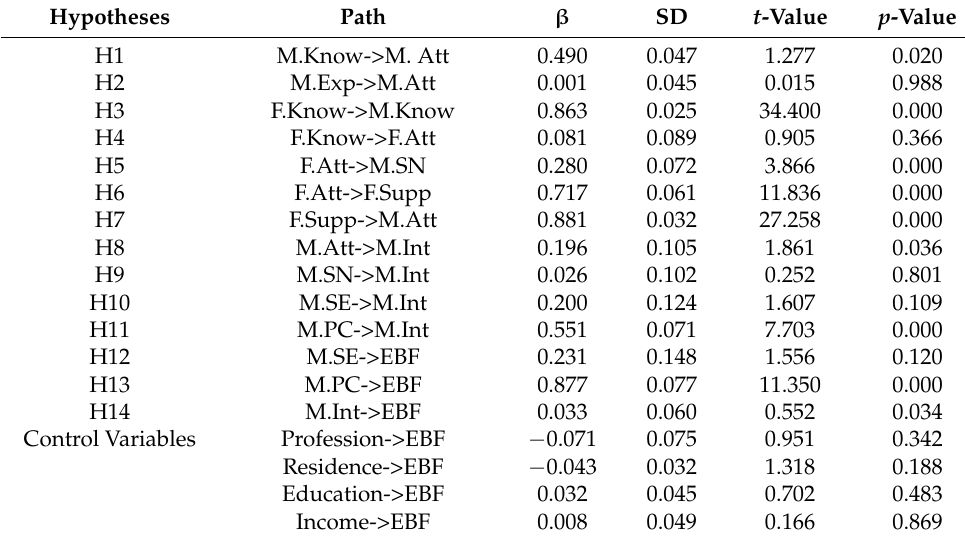
Table A1. Path coefficients of SEM (using cesarean delivery sub-sample).